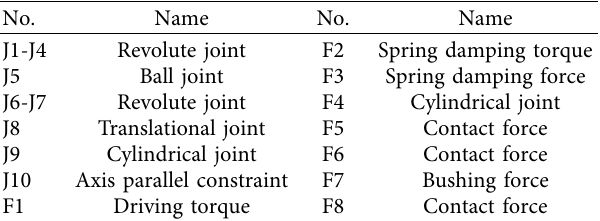
Table 3: Constraint table of tracked vehicle action system model. No.